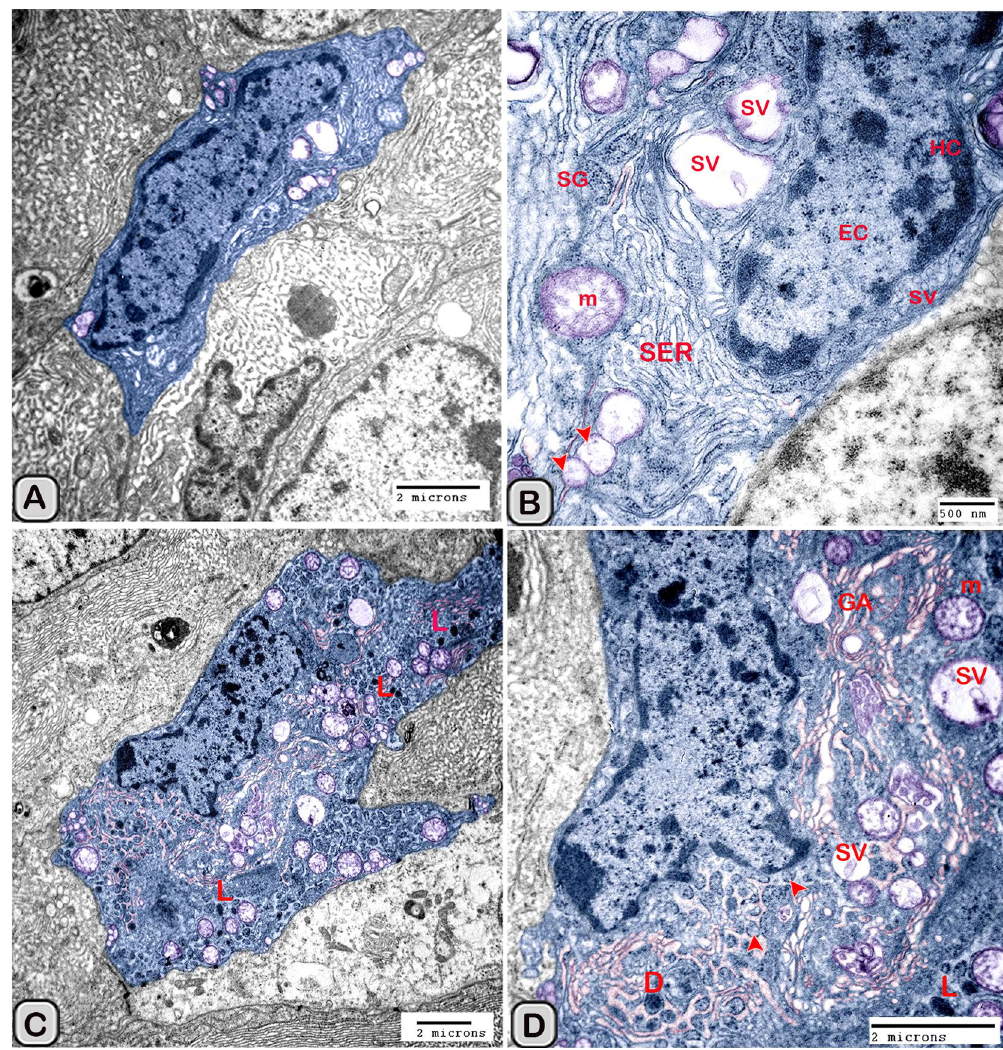
Figure 18. Digitally colored transmission electron microscope images of Macrophage among the epithelium of Soay ram seminal gland in the melatonin treated groups (A–D) . (A,B) The cytoplasm contained a well- developed tubulo-vesicular endosomal system (Tu), smooth endoplasmic reticulum (SER), secretory vesicles (Sv) and a well-developed Golgi (GA). In addition, the dense bodies (DB) and lysosomes (L) were more obvious compared to the control